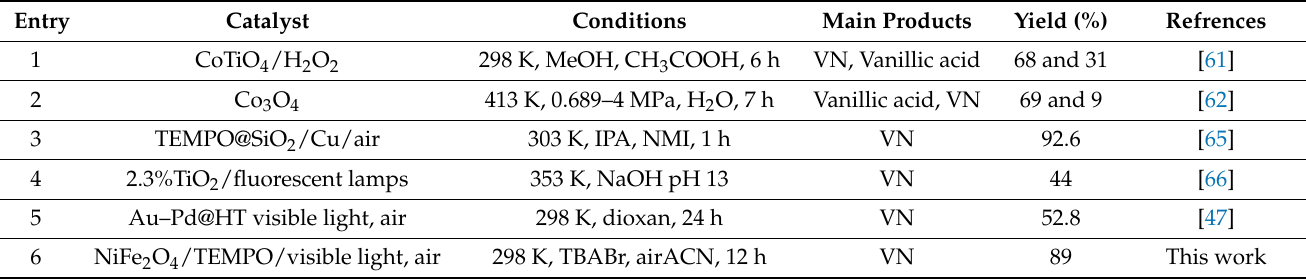
Table 3. Vanillyl alcohol oxidation comparative studies.